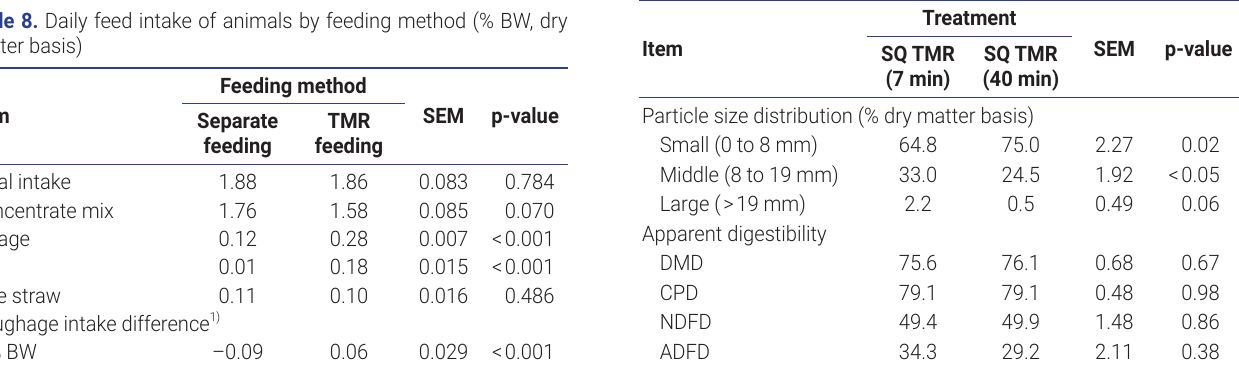
Table 9. Effect of mixing time on the particle size distribution and apparent in vivo nutrient digestibility of Sasa quelpaertensis Nakai TMR (% DM basis) Item